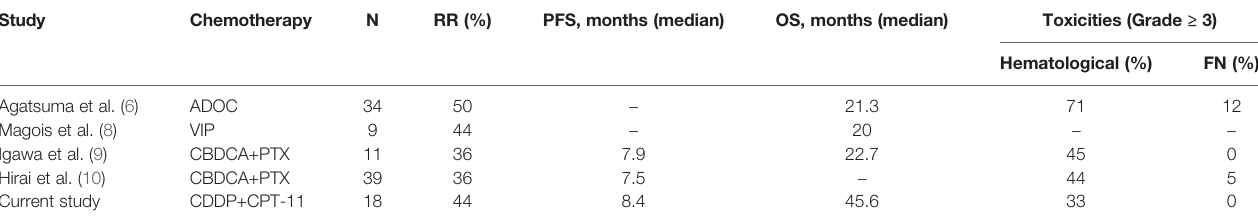
TABLE 5 | Previously reported platinum-combination chemotherapy for unresectable/metastatic thymic